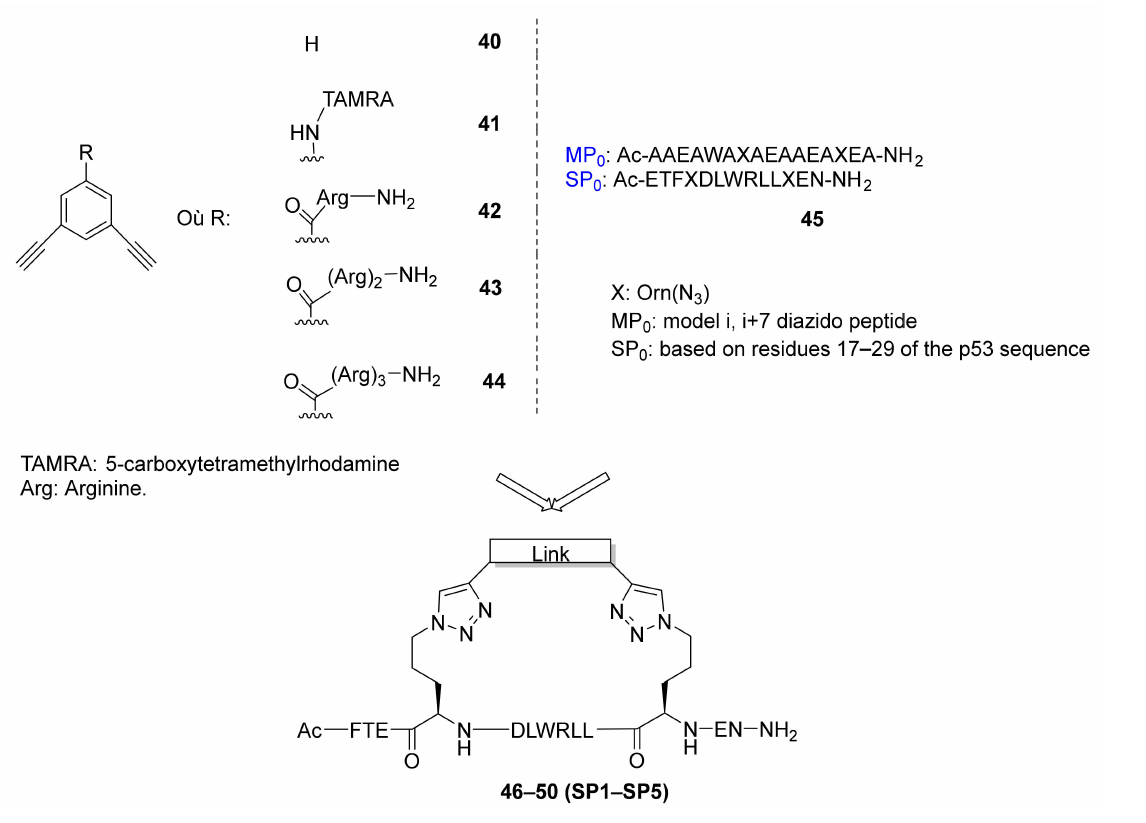
Figure 19. General structure of the stapled bis-triazolyl peptide product, SP1–SP5 ( 46 – 50